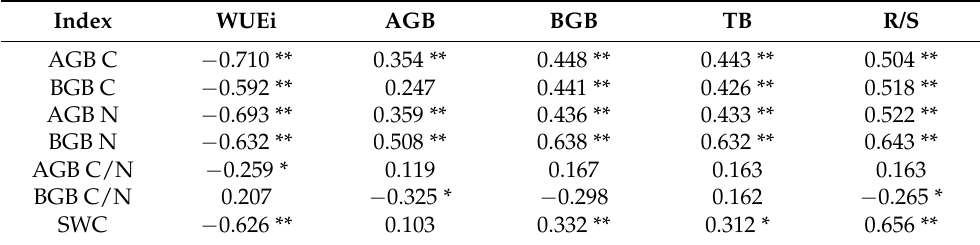
Table 5. Correlation among aboveground biomass (AGB), belowground biomass (BGB), total bio- mass (TB), BGB to AGB ratio (R/S), carbon (C), nitrogen (N) concentrations, soil water content (SWC) and intrinsic water use efficiency (WUEi).